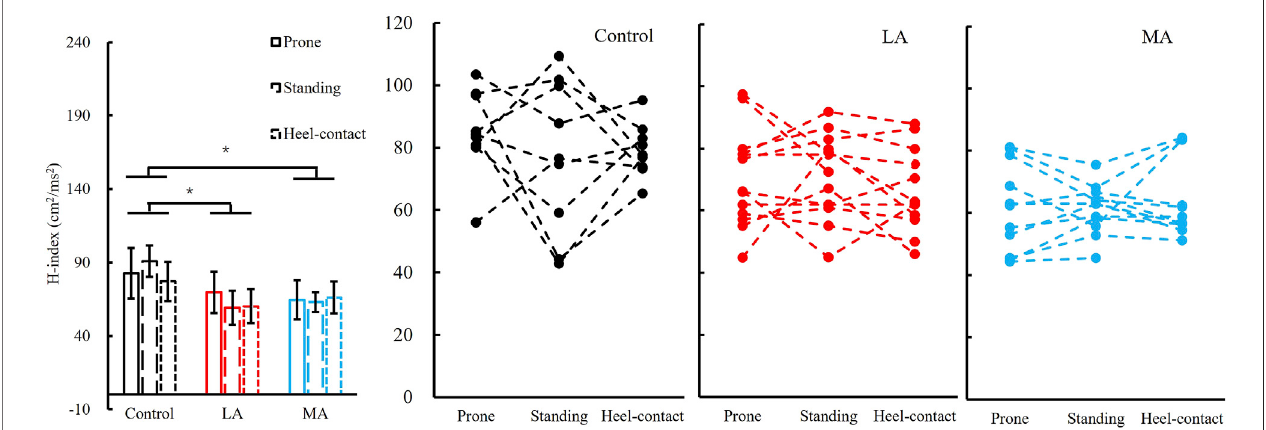
FIGURE4| Leftpanel:H-index(Mean±SEM)ofthreegroups(control,LA,andMA)withallpostures(prone,standing,andheel-contact)combinedsincetherewas no posture difference detected. * indicates a signi fi cant pairwise difference between two postures. Right three panels: individual data points in the control, LA, and MA groups are presented for all three